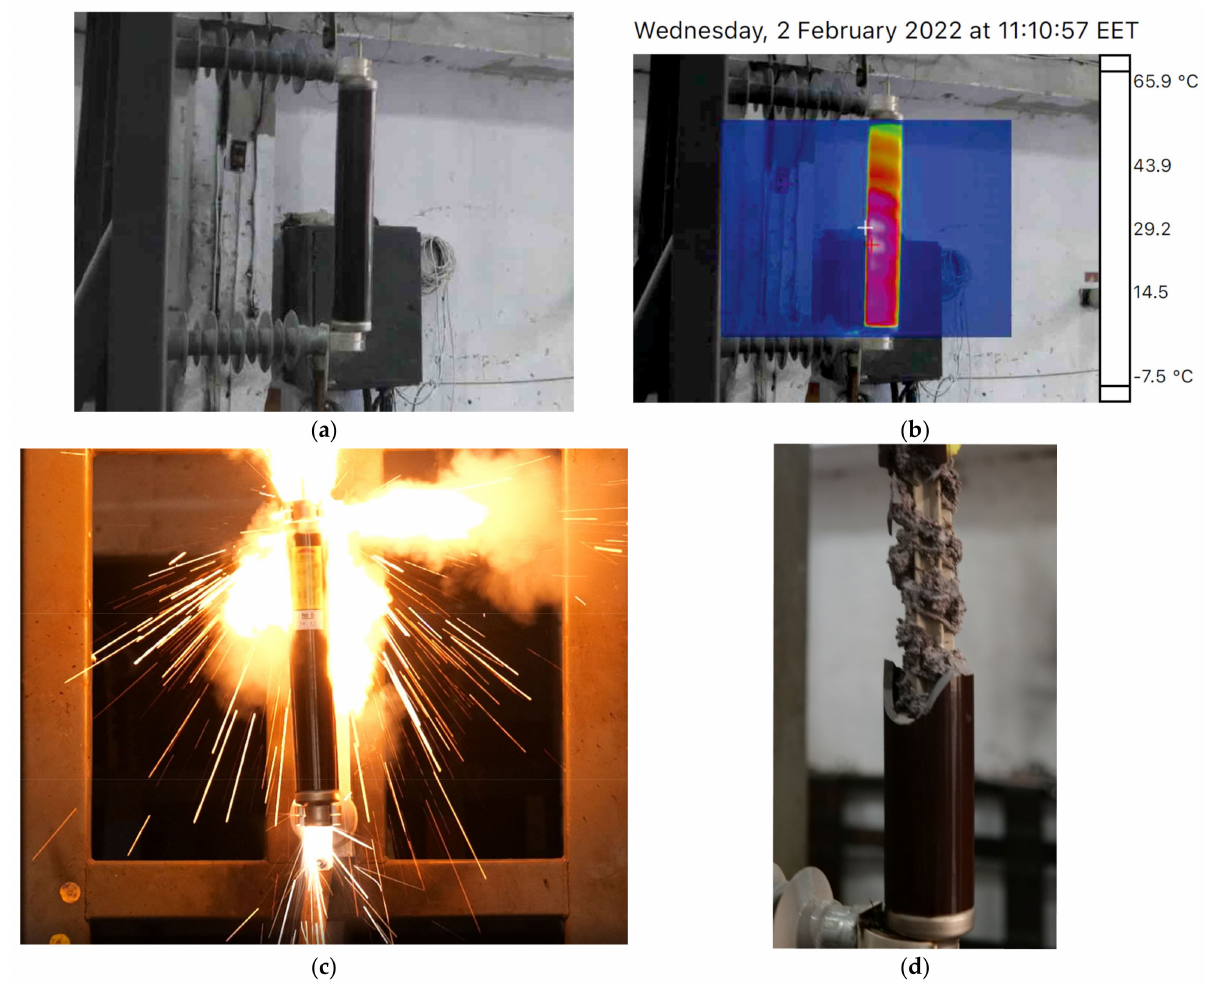
Figure 20. Images from the HV fuse experiments: ( a ) normal operation; ( b ) real-life termovision during experiment; ( c ) malfunction of the HV fuse’s caps; ( d ) overheating of the HV fuse with ceramic